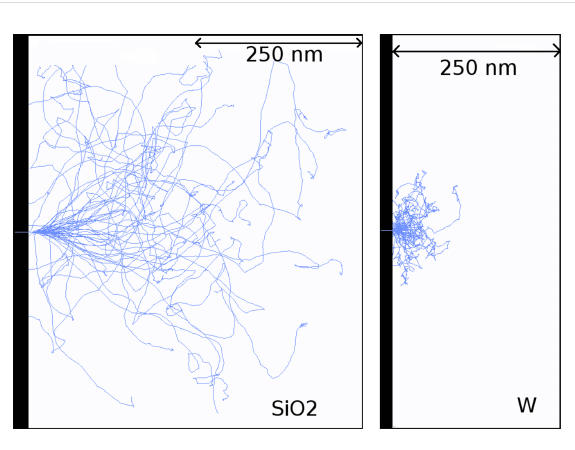
Figure 3: Snapshot of 50 simulated electron trajectories in the SiO 2 substrate (left) and in the nanostructured deposit material W (right, representative for material deposit). The width of the screenshot windows corresponds to 500 nm.